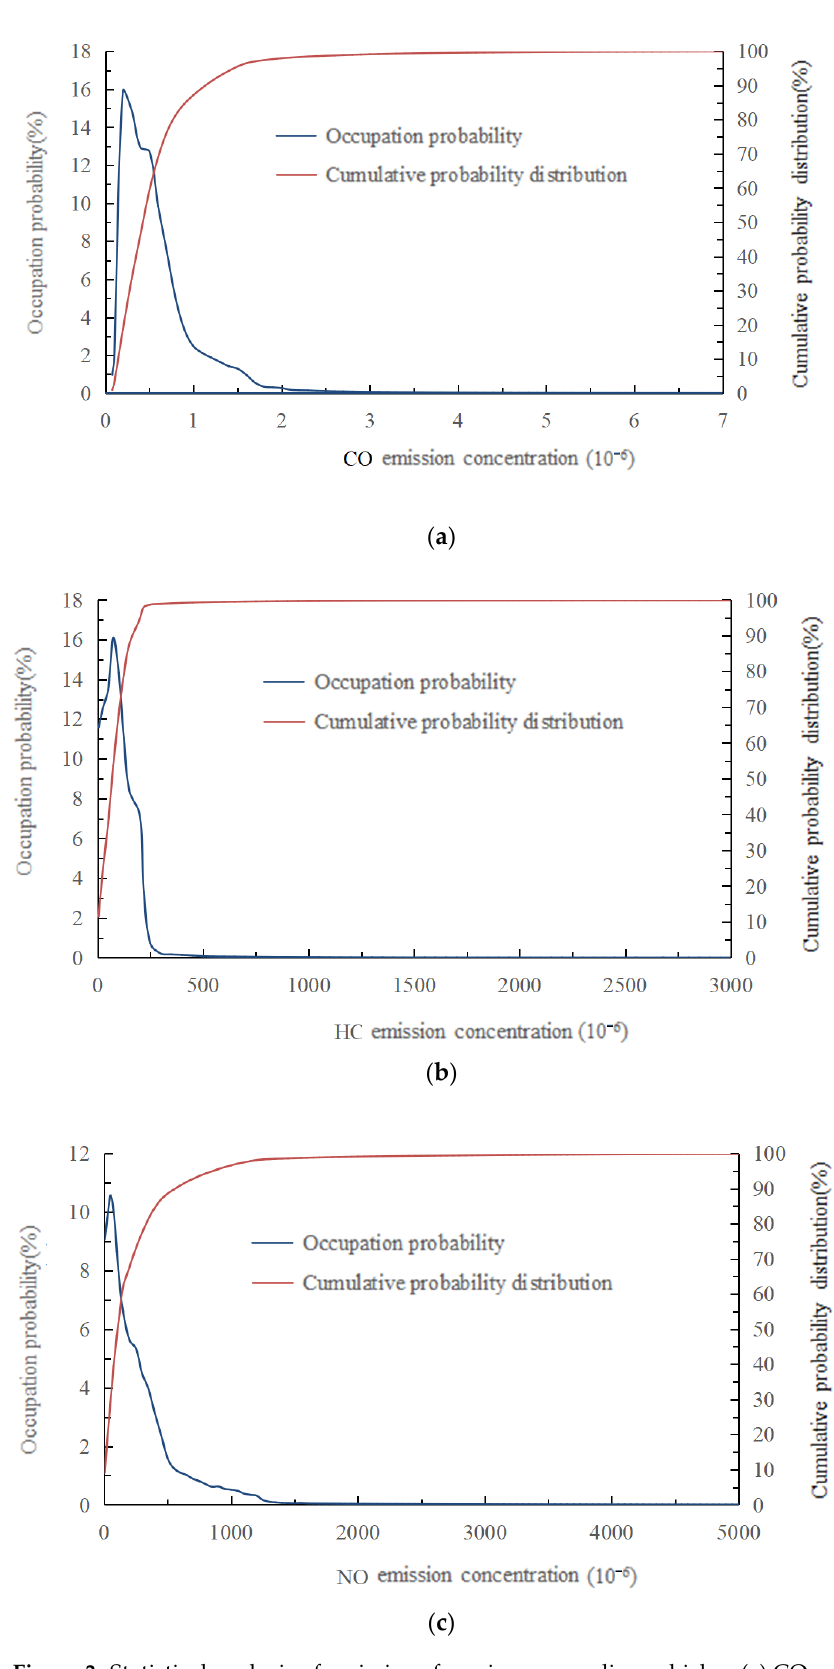
Figure 3. Statistical analysis of emissions from in-use gasoline vehicles. ( a ) CO emissions; ( b ) HC emissions; ( c ) NO emissions.